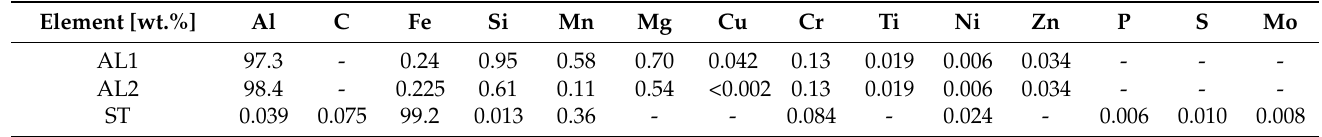
Table 1. The chemical composition of raw